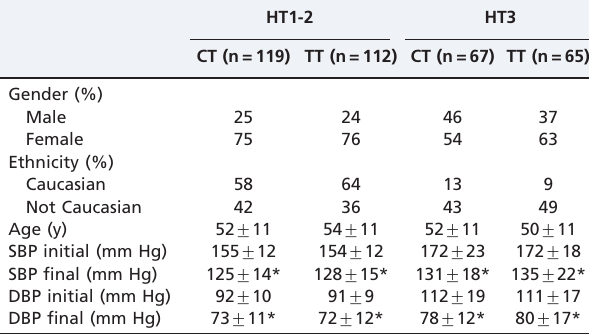
Table 1 - Demographic and clinical characteristics.